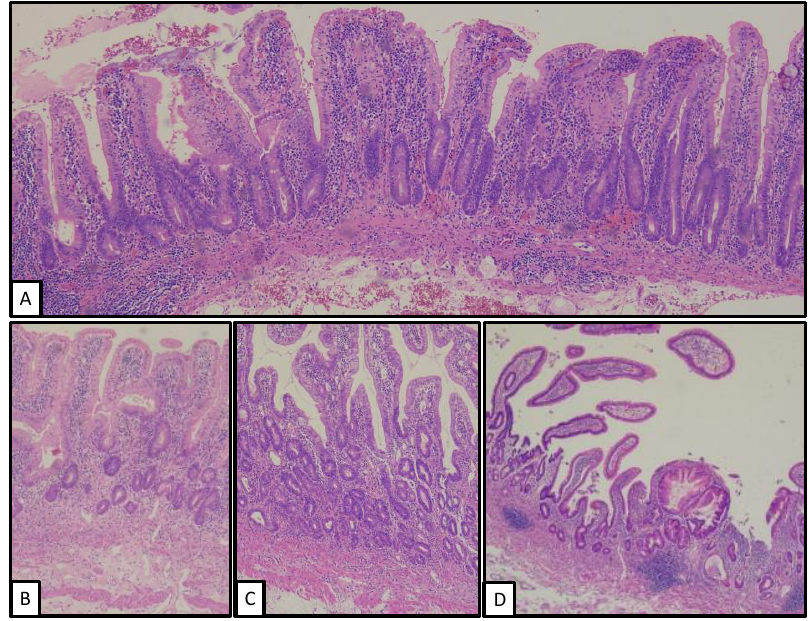
Figure 1. Low-power view of several portions of the small bowel wall showing Brunner’s gland agenesia ( A ), chronic inflammation ( B ), low-grade ( C ), and high-grade ( D ) epithelial dysplasia.